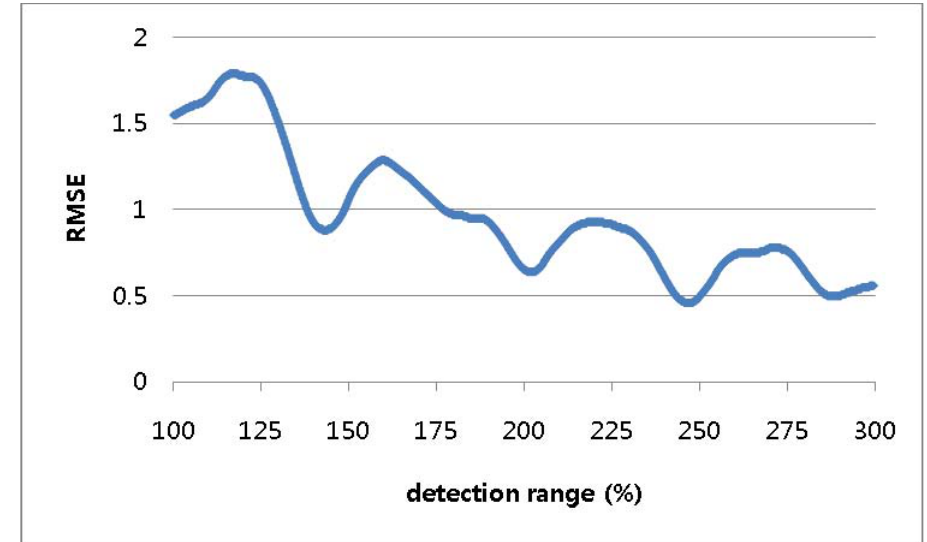
Figure 13. RMSE for detection ranges varying to 300% in 3-dimensional-space numerical approach.